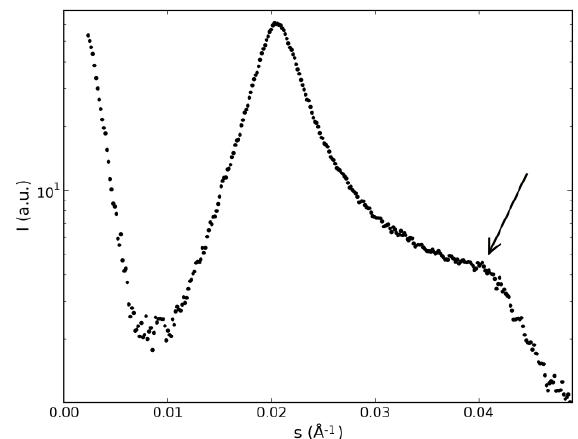
SO /1-dodecanol/H O; N phase, 2 4 2 D